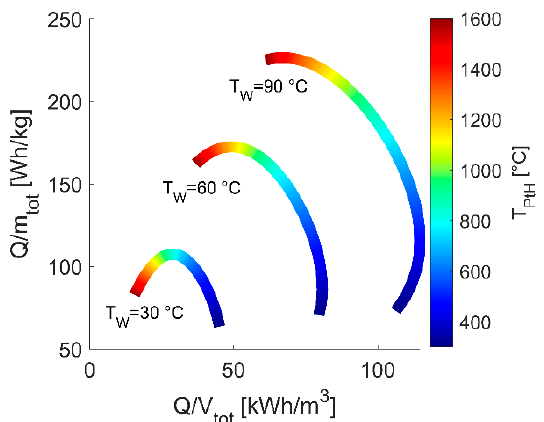
Figure 2. Systemic storage densities as a function of maximum permitted surface temperature ( T W ) and maximum solid media storage temperature ( T PtH ).